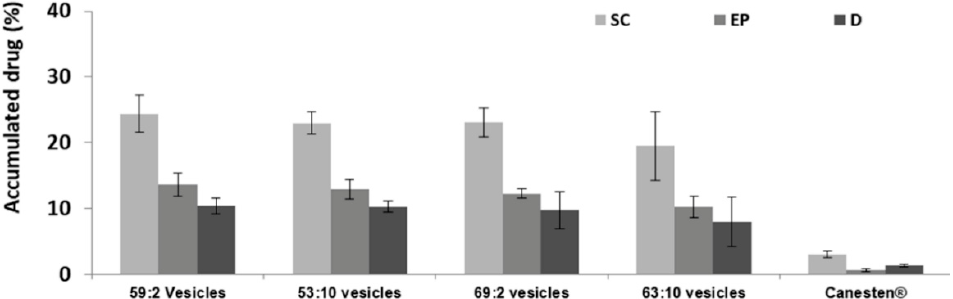
Figure 4. Cumulative amount of clotrimazole accumulated in the stratum corneum (SC), epidermis (EP), and dermis (D) after 8 h of treatment with the clotrimazole-loaded three-dimensionally-structured hybrid vesicles or Canesten ® cream. Bars represent the mean ± standard deviation (error bars) of at least six independent experimental determinations.